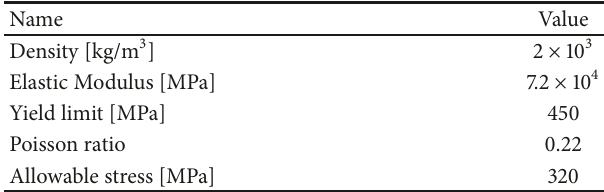
Table 3: Material properties of main